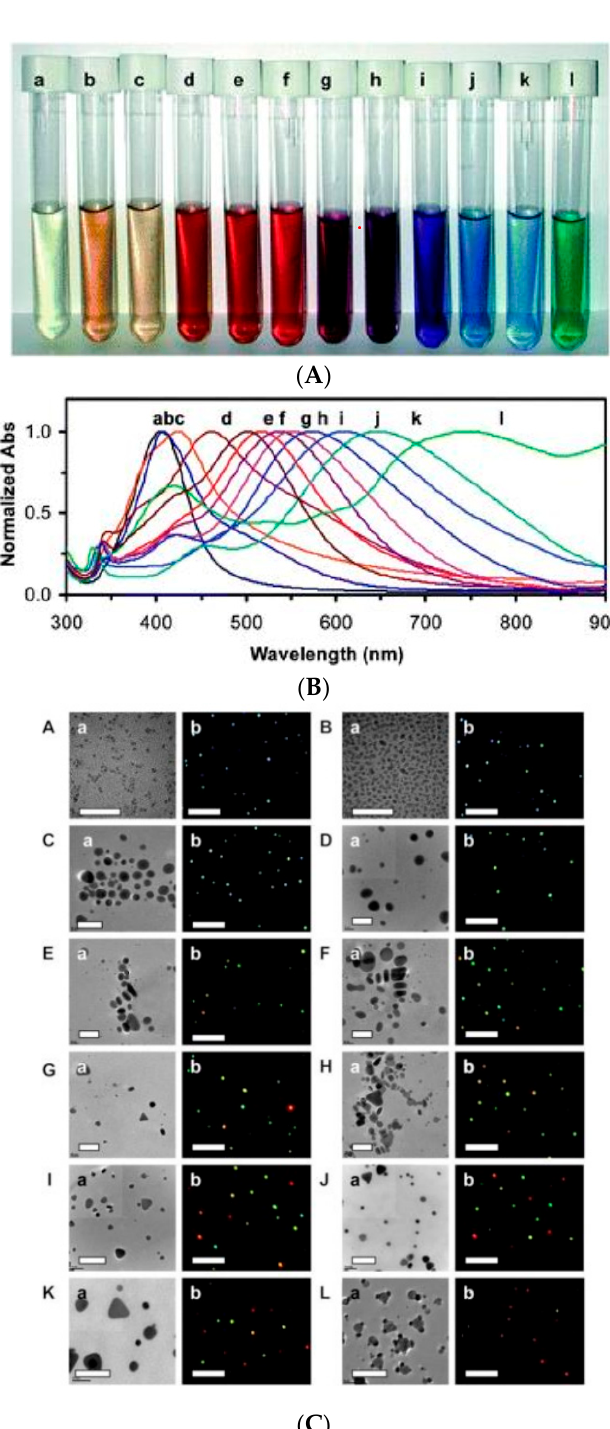
Figure 5. The change of color of colloidal solution depending on size and shape of silver nanoparticles in ( A ) and related optical absorption spectra ( B ); ( C ) The Figures (A–L) show the TEM images ( a ) related to the di ff erent shapes of Ag nanosystems and the NPs imaged under optical di ff raction limit ( b ). The scale bars in ( a ) are 40 and 100 nm for (A–H) and (I–L), and 10 µ m in ( b ), respectively. The scale bars in ( b ) represent the distances among NPs, but not the sizes of NPs